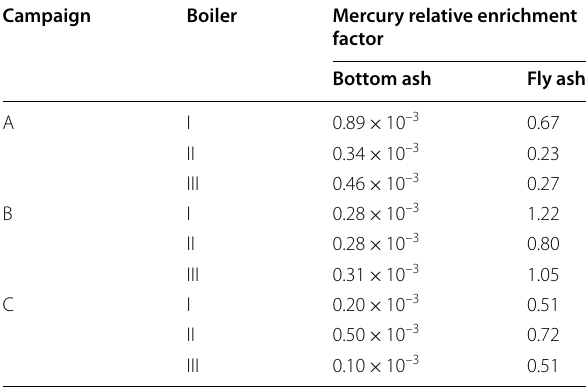
Hg in bottom ash is below the MDL and calculated as 1/2 of the MDL